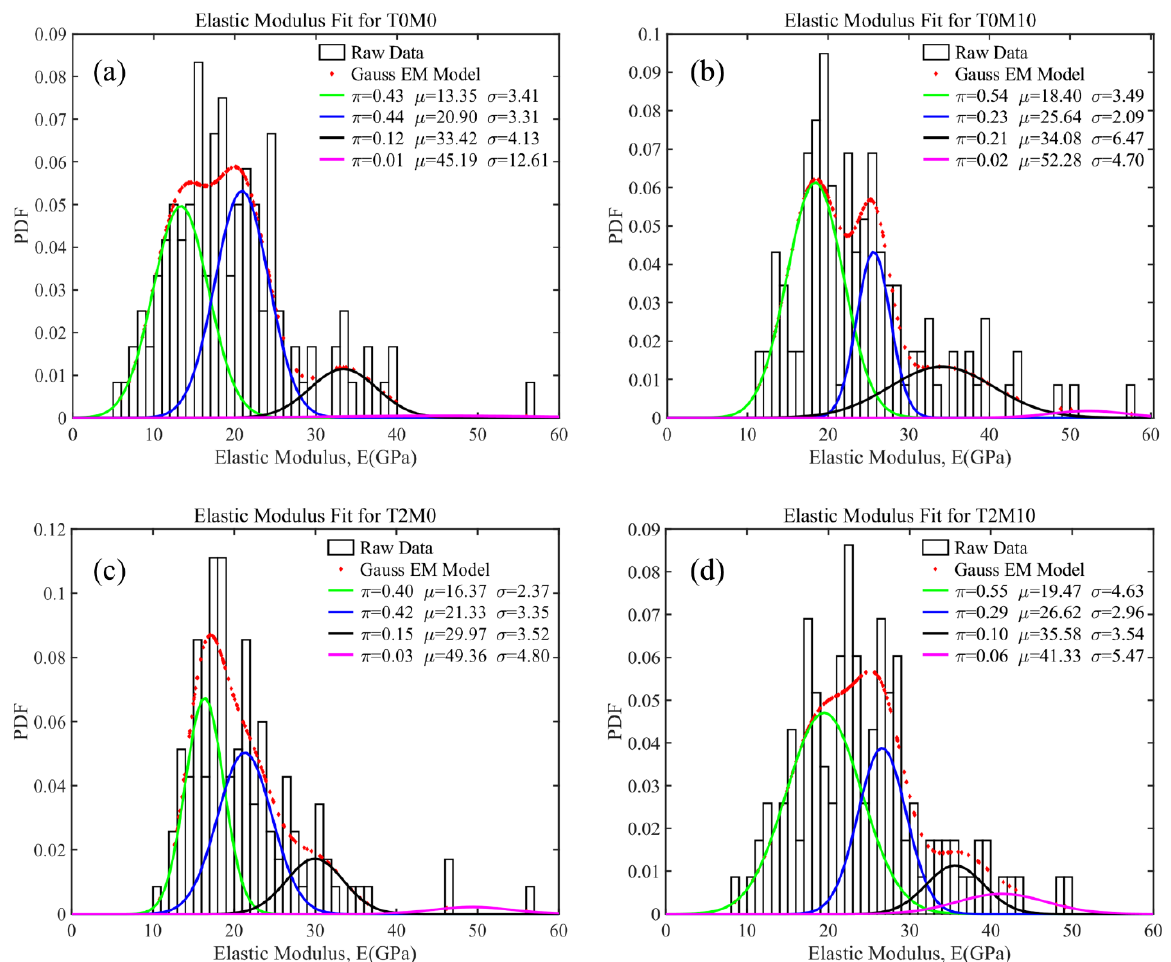
Figure 11. Deconvolution results of elastic modulus for the MK blended pastes with BTE: ( a ) T0M0; ( b ) T0M10; ( c ) T2M0; ( d ) T2M10.